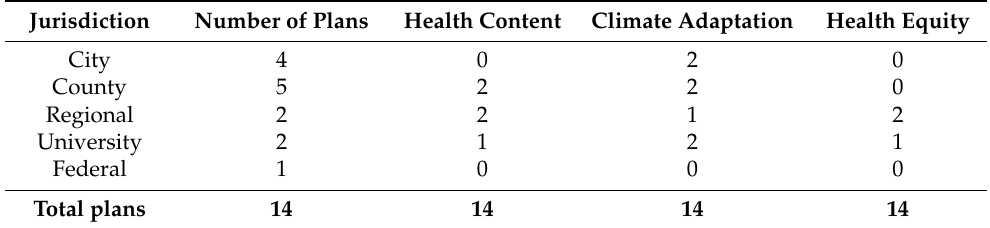
Table 1. Compilation of plans reviewed by LHDs and content related to health, climate adaptation and health equity.